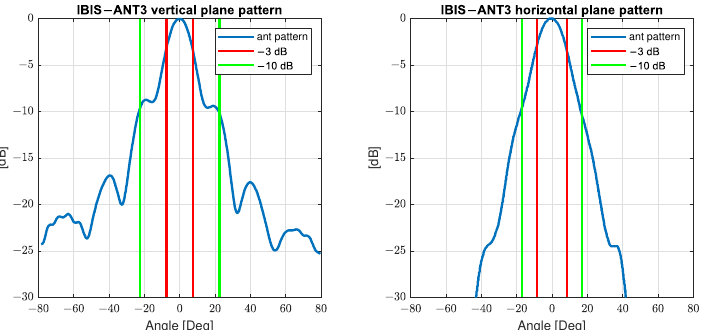
Figure 2. Antenna pattern for the standard antenna of the IBIS-S, vertical and horizontal (based on the User-Manual).